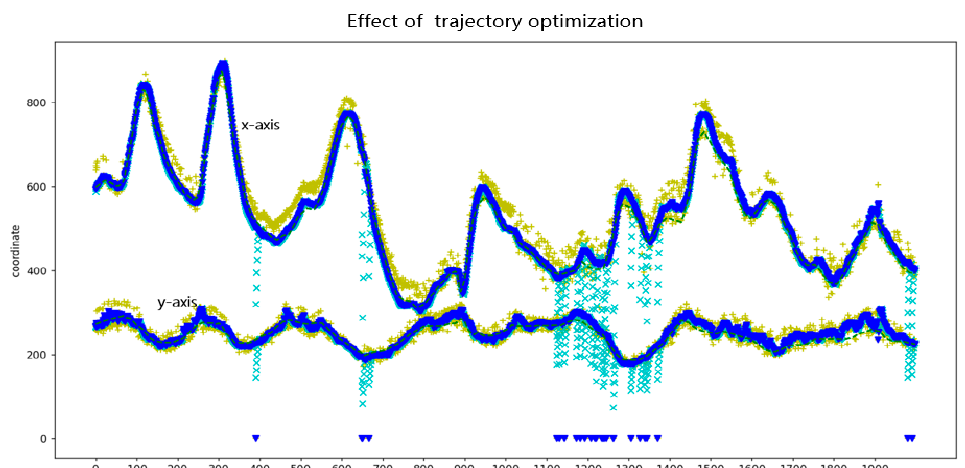
Figure 11. Locations optimized by trajectory optimization (partial).